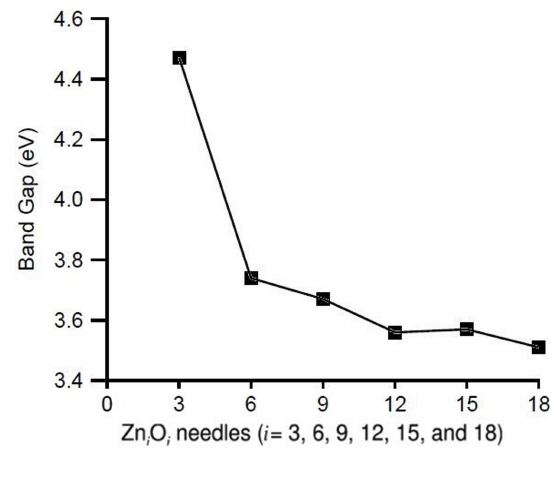
Figure 6. Band gap trend for unpuckered Zn the B3LYP